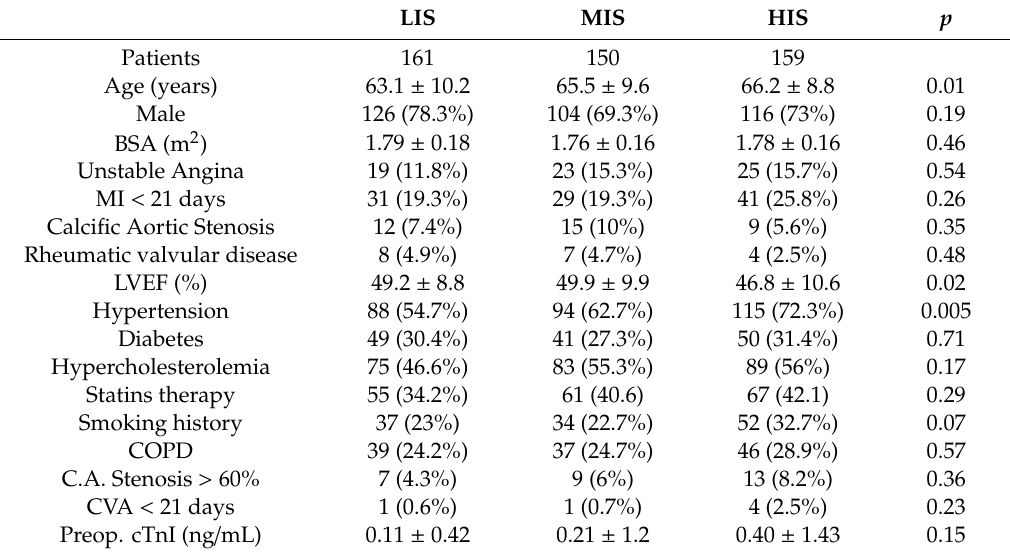
Table 1. Preoperative characteristics.